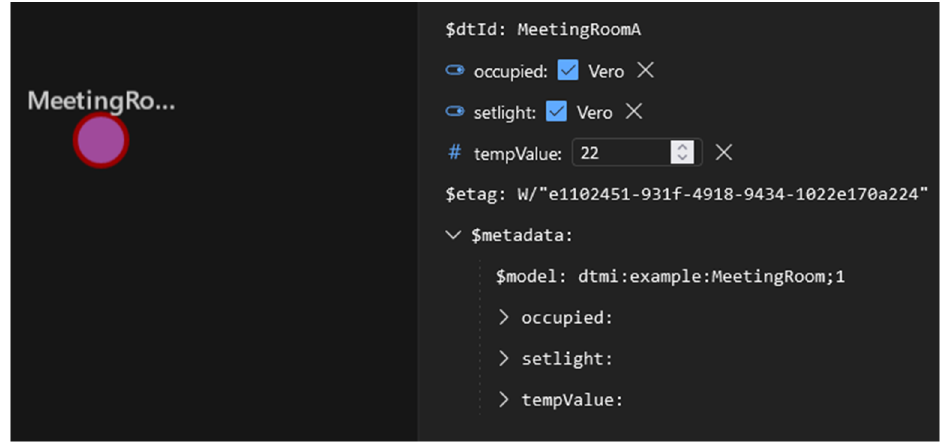
Figure 12. Graphical Representation of Digital Twin MeetingRoomA in Azure DT Explorer.